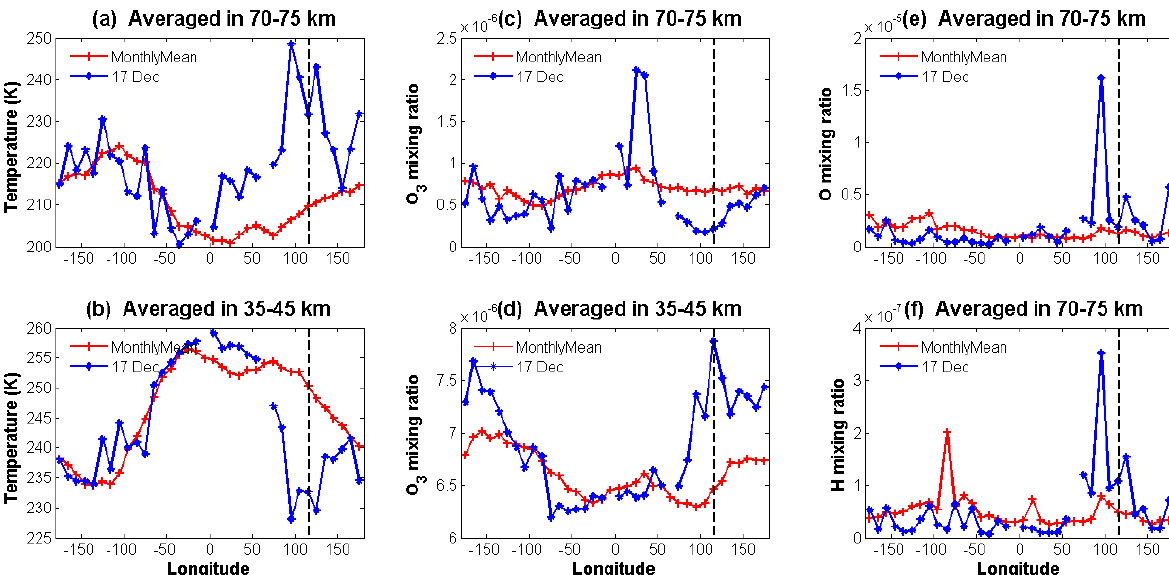
Figure 4. (a, b) Temperature variation with longitude, averaged between 35–45 ◦ N in the altitude range of 70–75 and 35–45km, respectively. (c, d) The same as (a) – (b) but for mixing ratio of O 3 . (e, f) The variations of mixing ratio of atomic H and O with longitude, averaged between 35–45 ◦ N in the altitude range of 70–75km. The red lines with pluses represent the monthly mean results in December 2014, and the blue lines with asterisks represent the daily mean results on 17 December. The black dotted lines in each plot indicate the longitude of the lidar site. Each data point is obtained by averaging within a longitude range of 10 ◦